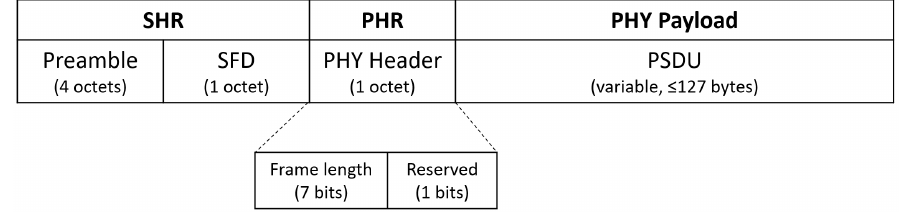
Figure 1. IEEE 802.15.4-2015 OQPSK-DSSS frame